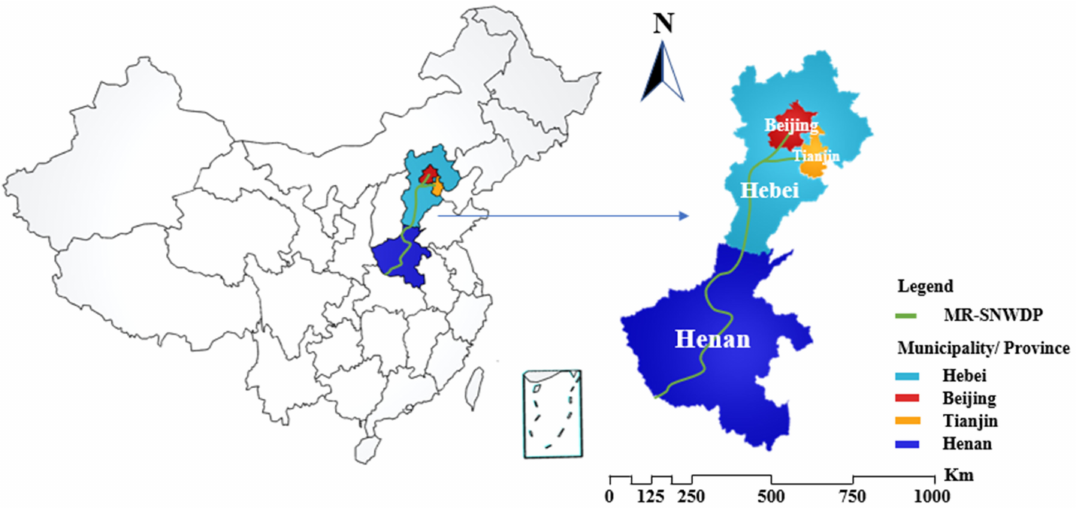
Figure 3. The map of the Middle Route of the South-to-North Water Diversion